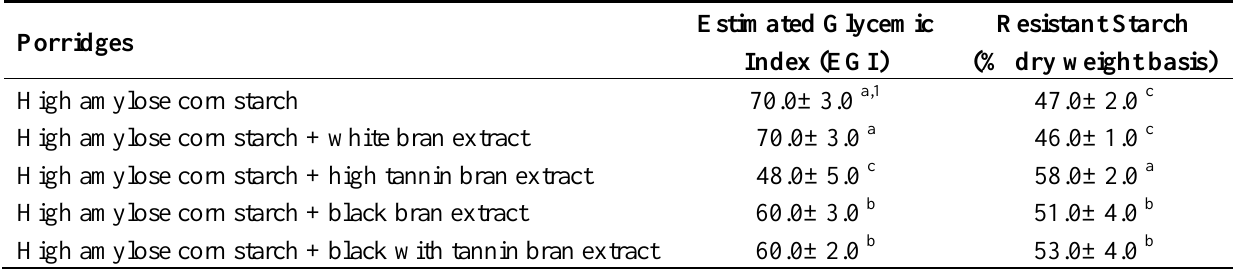
Table 4. Estimated Glycemic Index (EGI) and Resistant Starch (RS) Contents of High Amylose Corn Starch Porridge Cooked with Sorghum Bran Extracts.